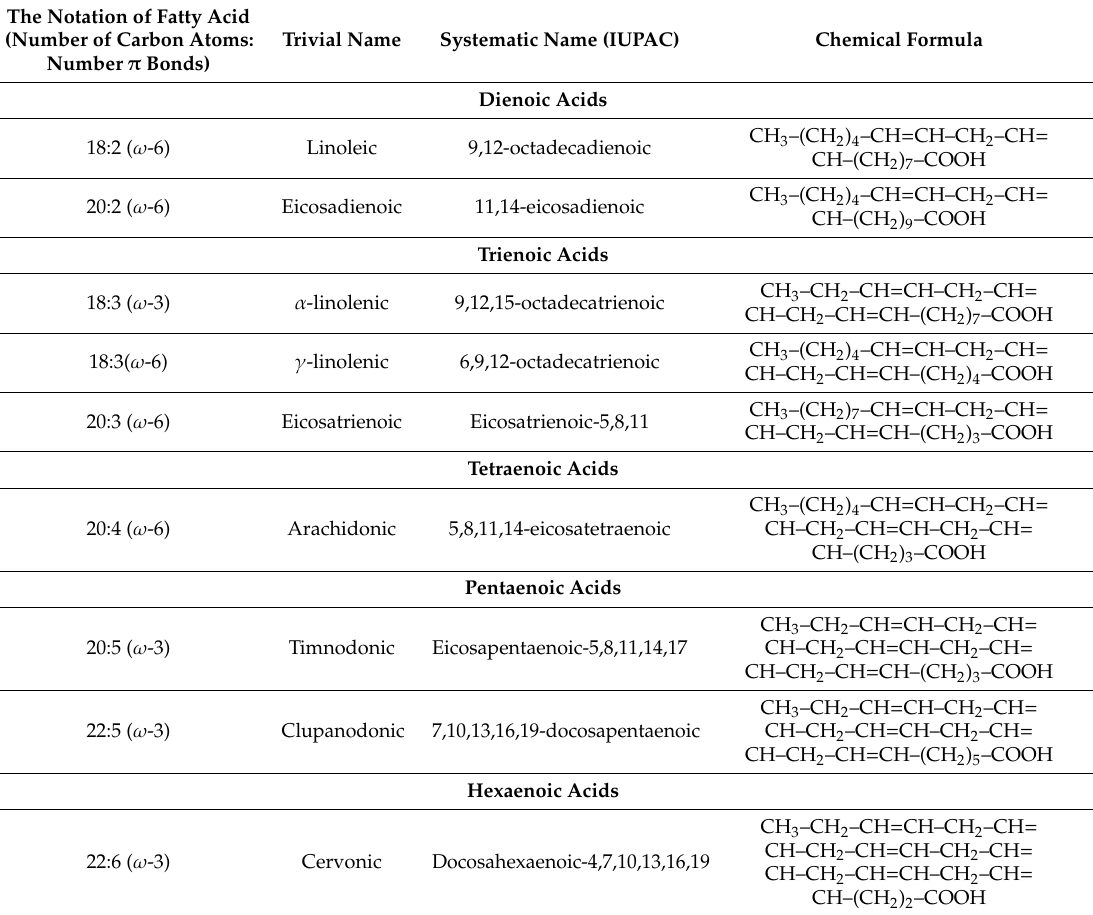
Table 3. The most physiologically important (common) polyunsaturated fatty acids. The Notation of Fatty Acid (Number of Carbon